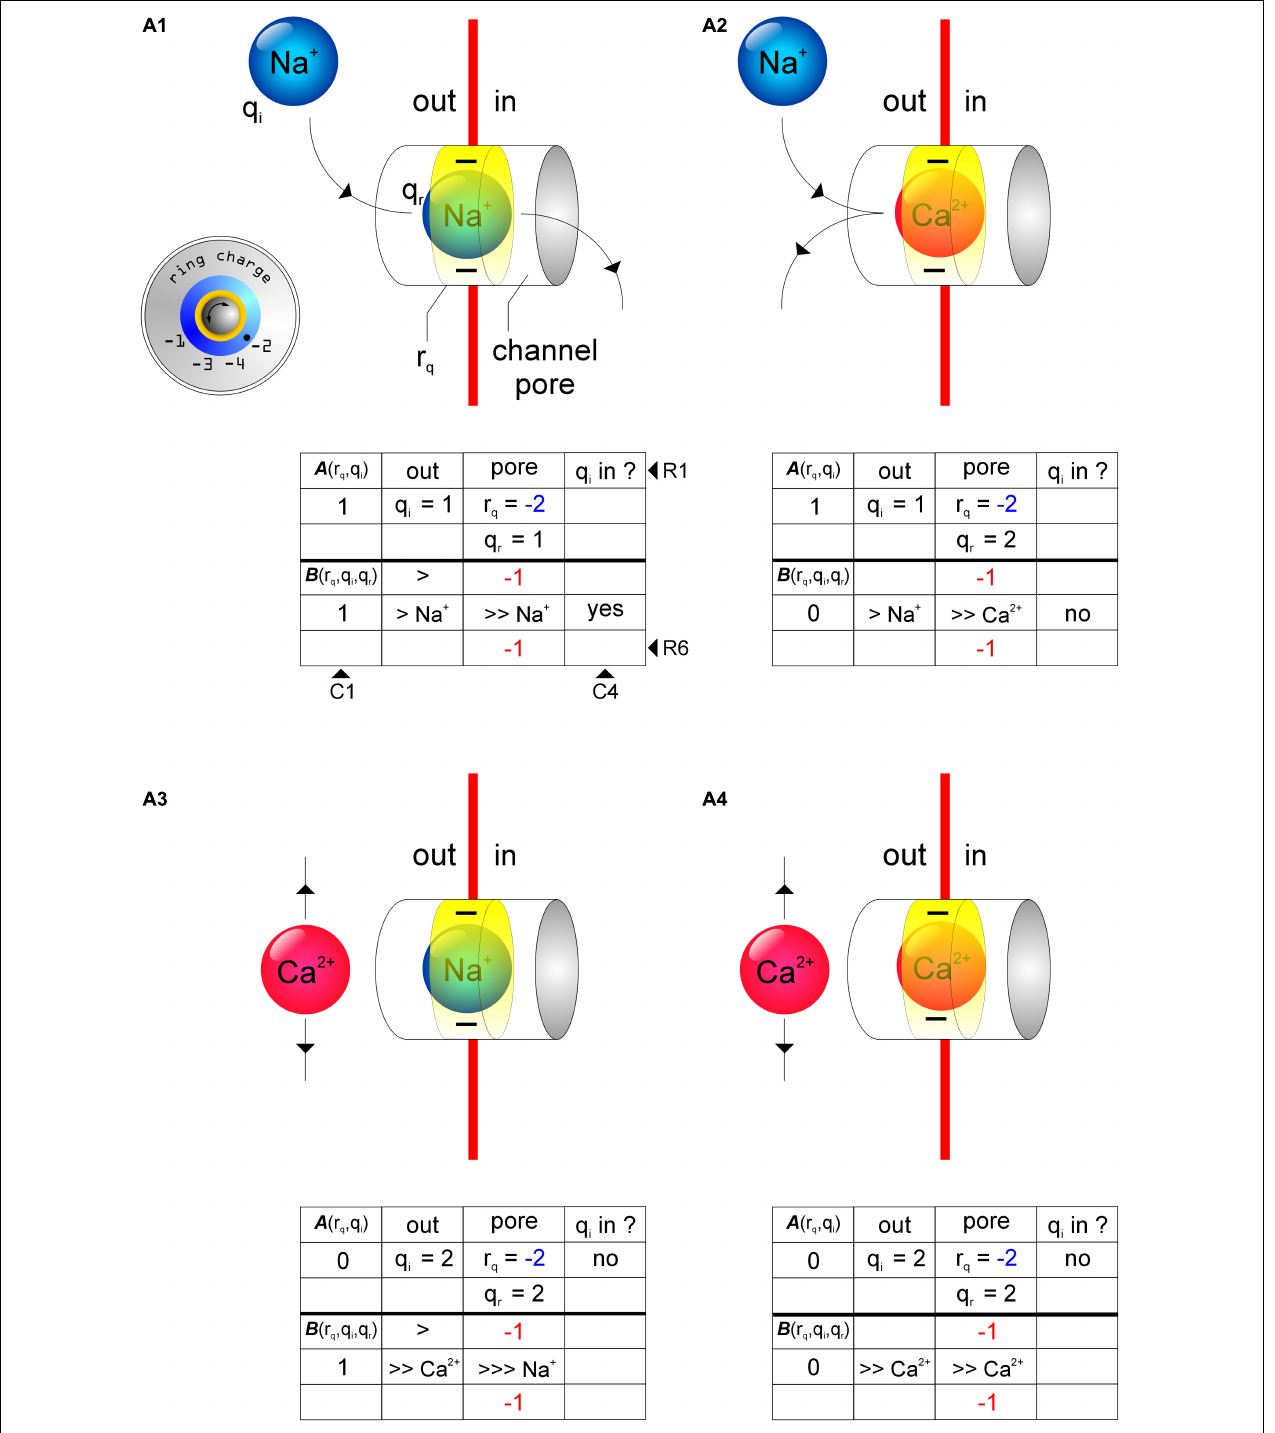
FIGURE 4 | Schematics of test configurations depicting the use of the charge permeability equation (1) to predict selectivity and permeability of cations in receptor channels with r q = –2 (ring charge dial, insets ). (A 1 ,A 2 ) Na + ( q i ) can displace itself (A 1 ) , but not Ca 2 + (A 2 ) , from the channel pore in receptors with r q = –2. (A 3 ,A 4 ) Attractivity of Ca 2 + ( q i ) in these receptor channels is, however, diminished thereby rendering them Ca 2 + impermeable. As before, tables underneath the schematics depict the working underlying computation of the terms A (cid:0) r q , q i (cid:1) (R2C1; R, row ; C, column ) and B ( r q , q i , q r ) (R5C1) associated with the charge permeability equation. > , electromotive force on q r exerted by q i (R4-6C2, R5C3); numbers colored red (R4C3, R6C3), total ring charge r q ( blue , R2C3) distributed around q r (R5C3).